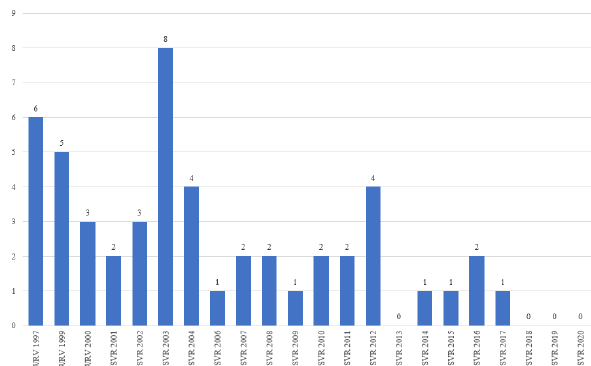
Figure 10. Overall distribution of papers from the “Multi-user and dis- tributed XR”